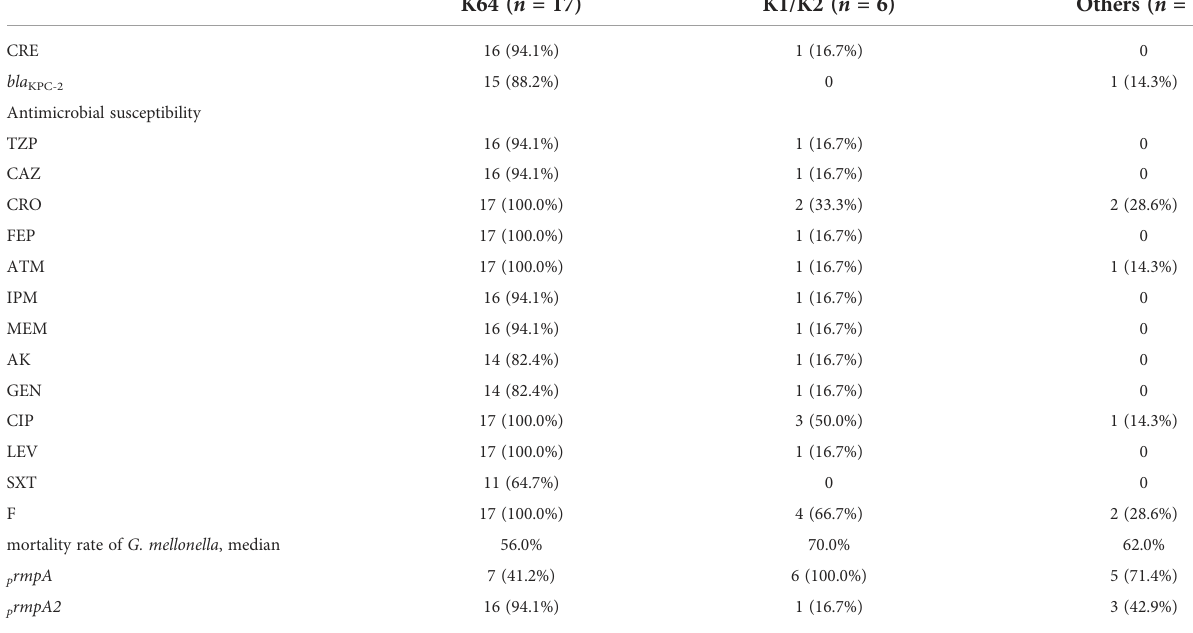
TABLE 2 Comparison of drug resistance and virulence among K64, K1/K2 and other serotype hvKP.